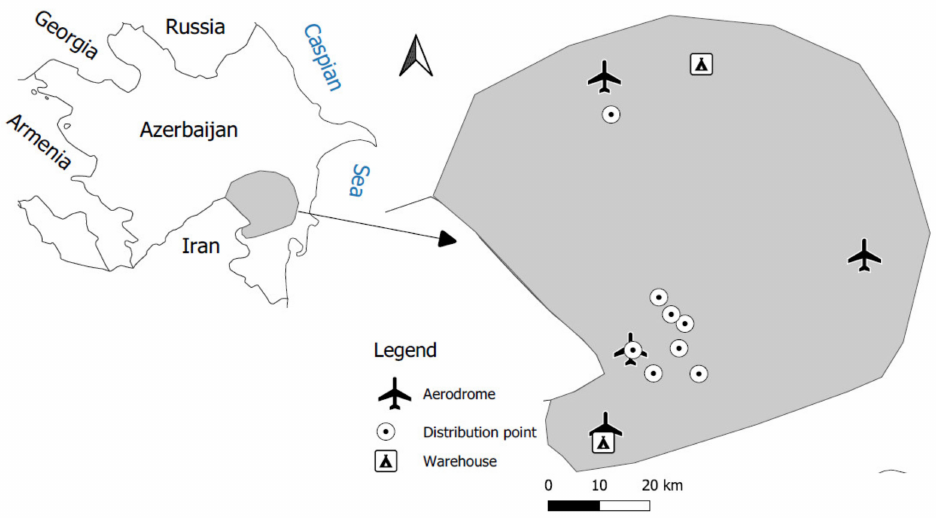
Figure 2. Scheme of the sampling area containing designated warehouses (2 sampling sites), aerodromes (4 sampling sites), and pesticide distribution sites (8 sampling